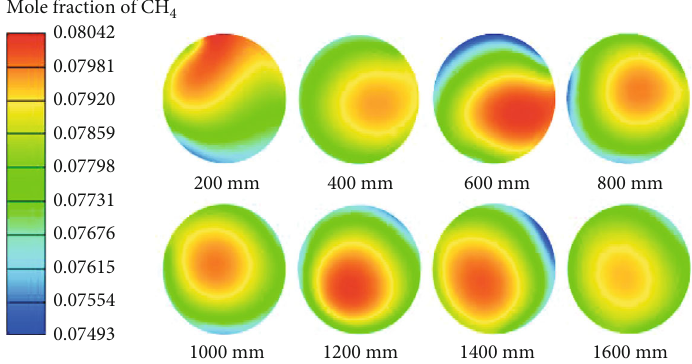
Figure 13: In fl uence of blade pitch in tubule zone on the uniformity of gas.